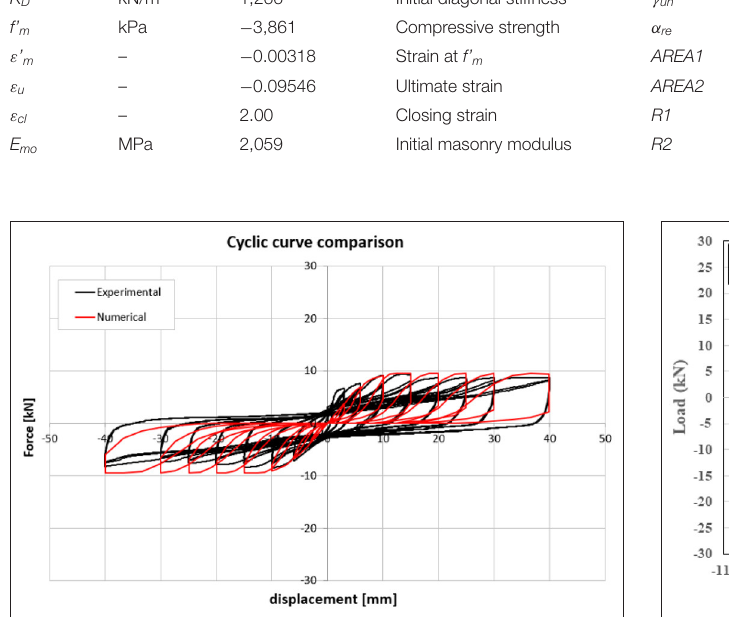
FIGURE 20 | Comparison between the force–displacement experimental and numerical curves of the semi-interlocking masonry (SIM) infill from semi-active spring model.